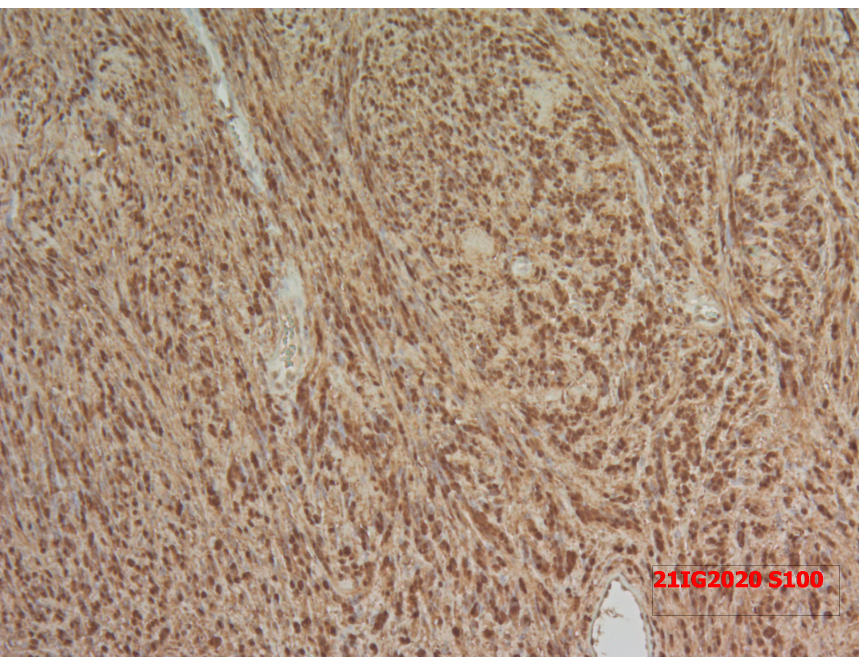
Figure 6. The Ki67 proliferation index showed a value lower than 5%; on immunohistochemistry, the protein S100 was positive while the relationship with actin was negative.